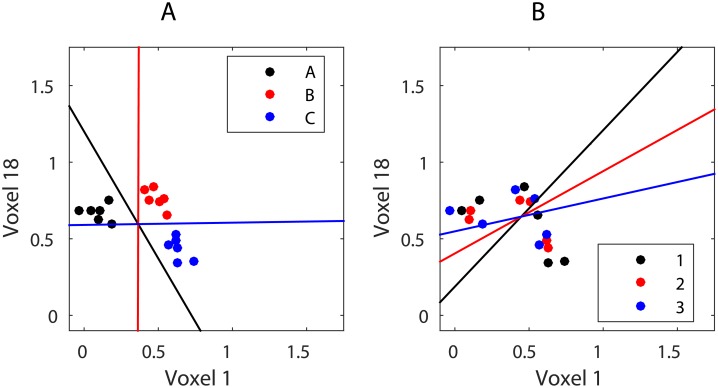
The scatter of item patterns and LDA between-class boundaries based on the two most informative voxels.(A) Item information. (B) Position information.